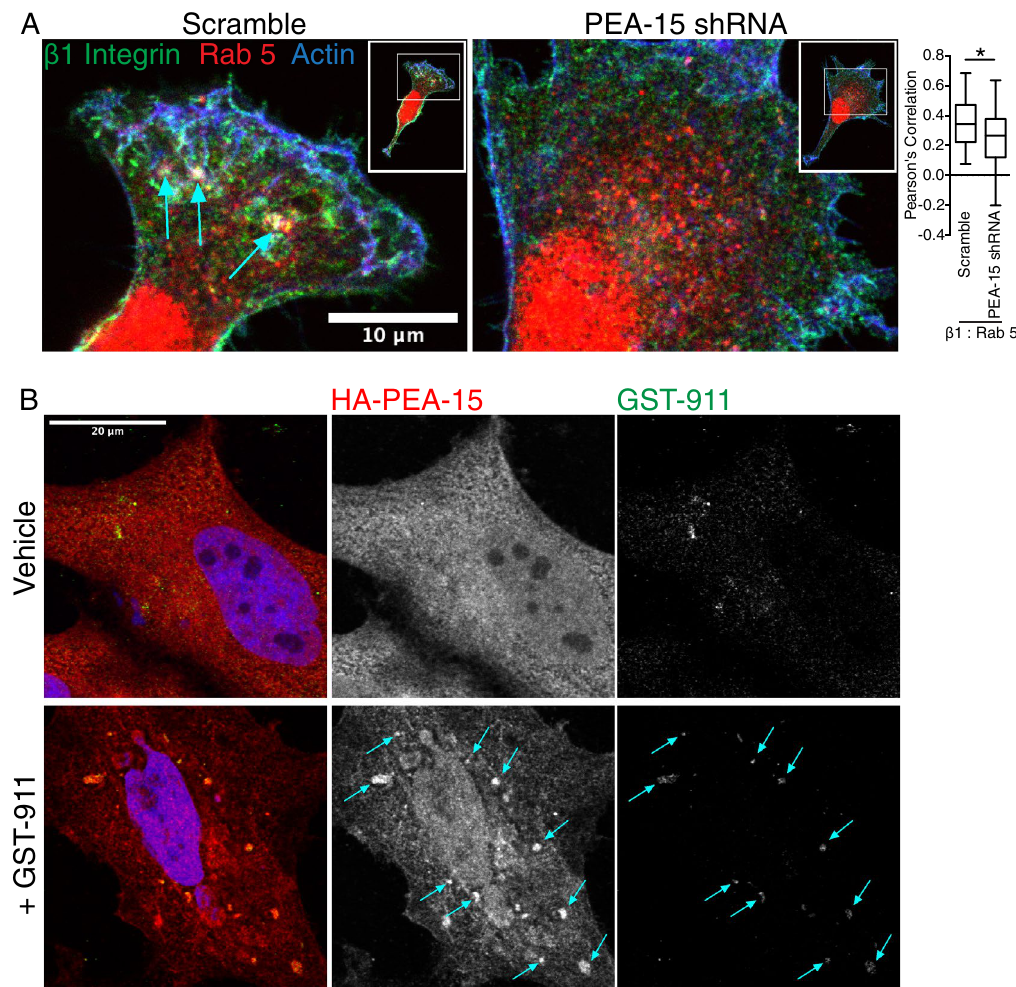
Figure 7. PEA-15 sorts β1 integrins to Rab5 endosomes. ( A ) Scramble and PEA-15 KD cells were allowed to adhere to FN-coated glass coverslips for 30 min. Cells were fixed and stained for β1 integrin, Rab5, and actin. Scale bar = 10 µm. Areas showing overlap between all three channels are indicated by white arrows. The Pearson correlation between β1 integrin and Rab5 endosomes was measured using ImageJ software (n = 37, * p < 0.05). ( B ) HeLa cells expressing HA-tagged PEA-15 were treated with or without GST-3FN9-11 (GST-911) and co-stained with antibodies against HA-tag and GST. Vesicular structures showing co-localized signal are indicated by blue arrows. Scale bar = 20